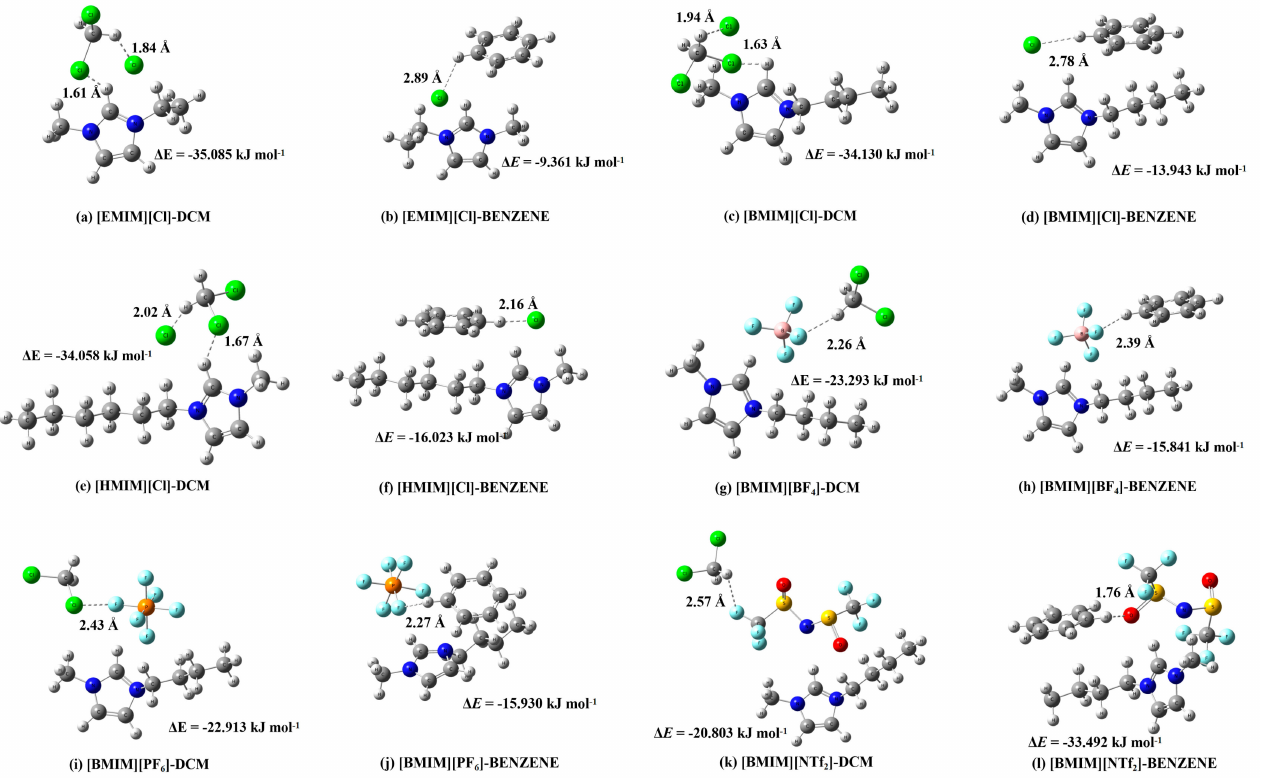
Figure 9. The optimized geometric structures obtained by Gaussian 09